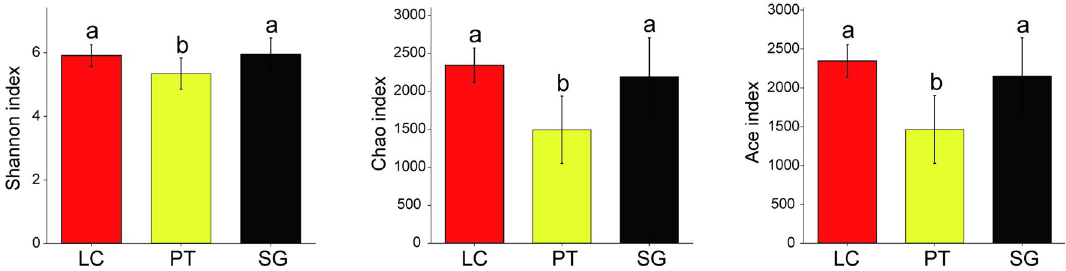
Fig 3. Bar chart for alpha diversity of the rhizosphere soil bacterial communities under three halophytes. Different lowercase letters into each column are significantly different (Tukey’s test, P < 0.05). LC, Leymus chinensis (Trin.) Tzvel.; PT, Puccinellia tenuiflora (Griseb.) Scribn. et Merr.; SG, Suaeda glauca (Bunge) Bunge.